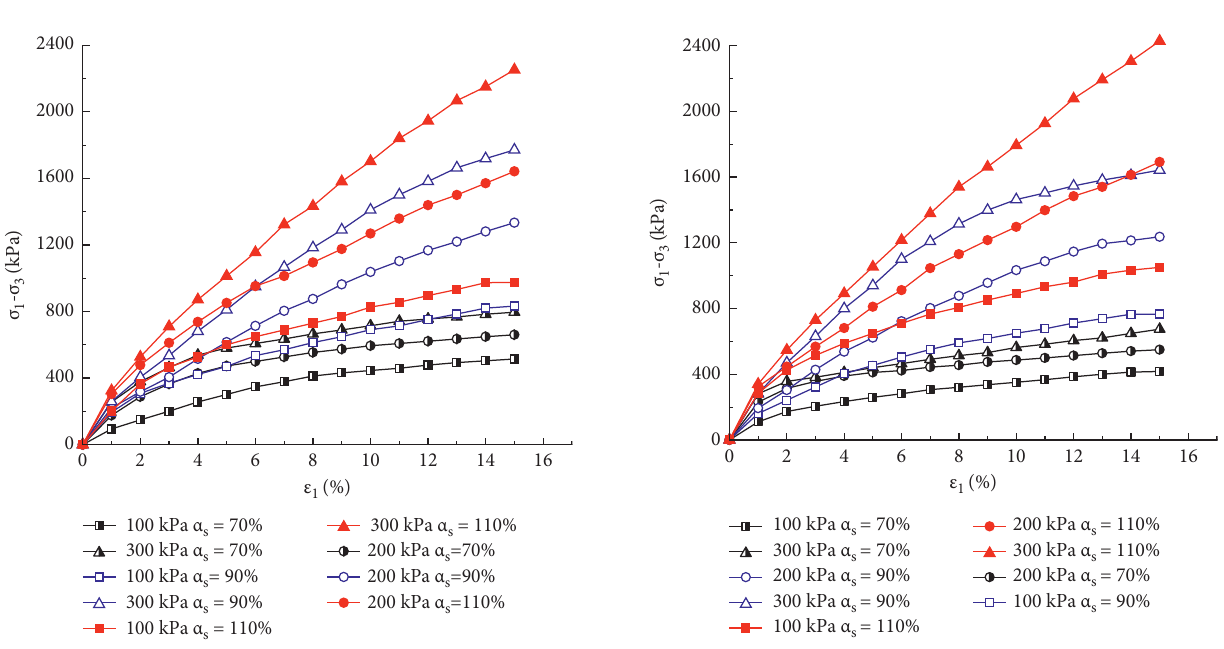
Figure 7: Relationship between principal stress difference and axial strain ( ω � 70%).